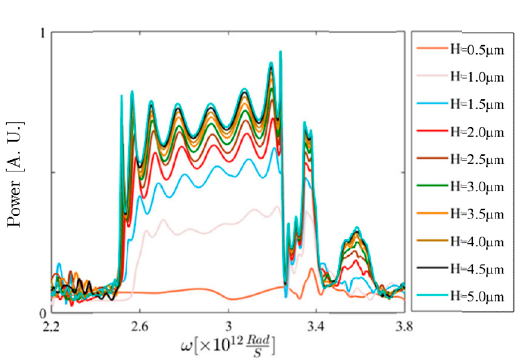
Figure 2. Power spectra of PhC waveguides with different pillar heights (H), a latticce constant a = 245 nm and a pillar radius of r = 0.2a.